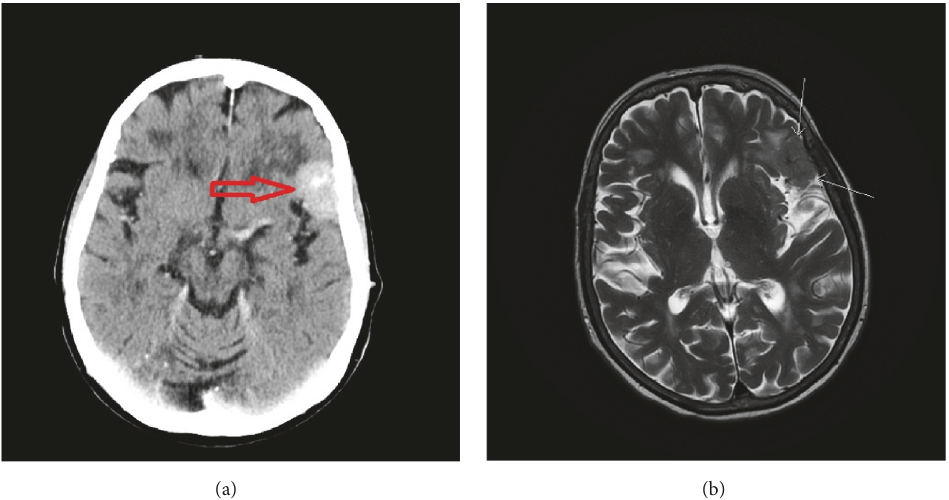
Figure 3: Imaging of meningioma of case II. (a) Contrast CT in the axial plane visualizing the meningioma (red arrow). (b) T2 weighted MRI in the axial plane visualizing the same meningioma (white